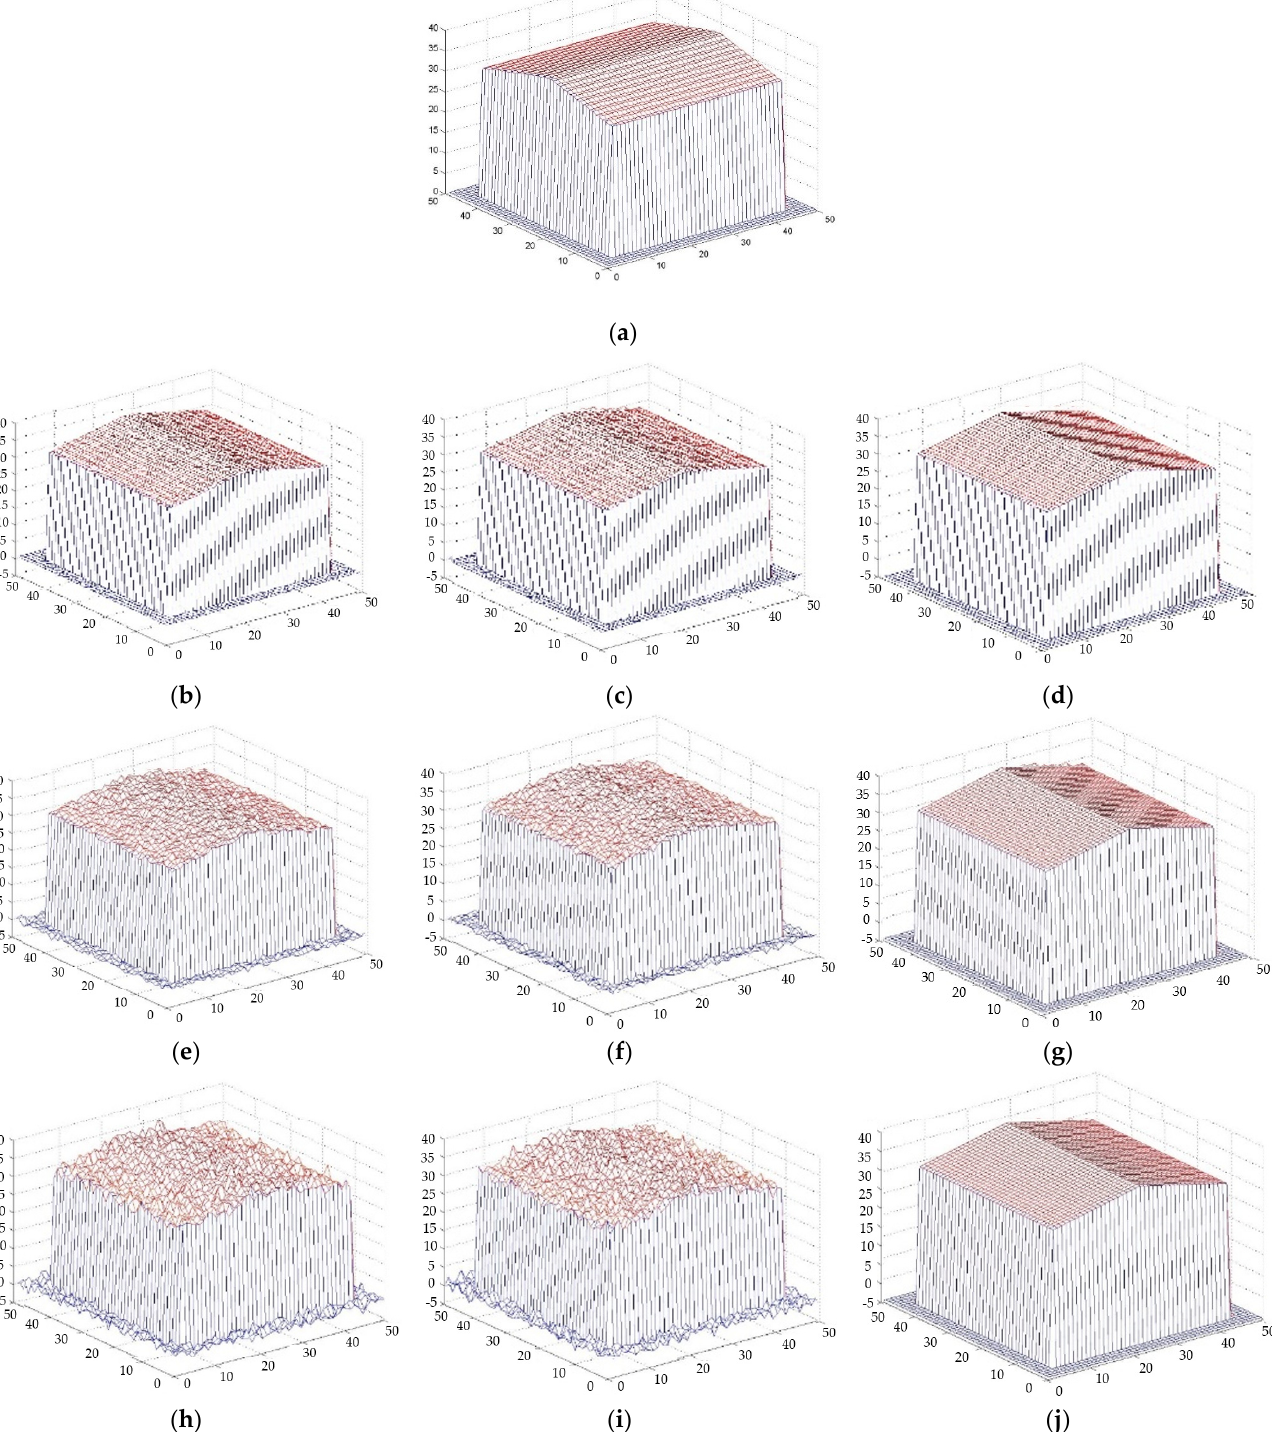
Figure 5. Comparison of the effect before and after the fusion of pitched-roofed buildings with different variance Gaussian noise. ( a ) DSM of the truth map for pitched-roofed building. ( b ) DSM 1 variance 0.1. ( c ) DSM 2 variance 0.1. ( d ) DSM after fusion variance 0.1. ( e ) DSM 1 variance 0.5. ( f ) DSM 2 variance 0.5. ( g ) DSM after fusion variance 0.5. ( h ) DSM 1 variance 1. ( i ) DSM 2 variance 1. ( j ) DSM after fusion variance 1.